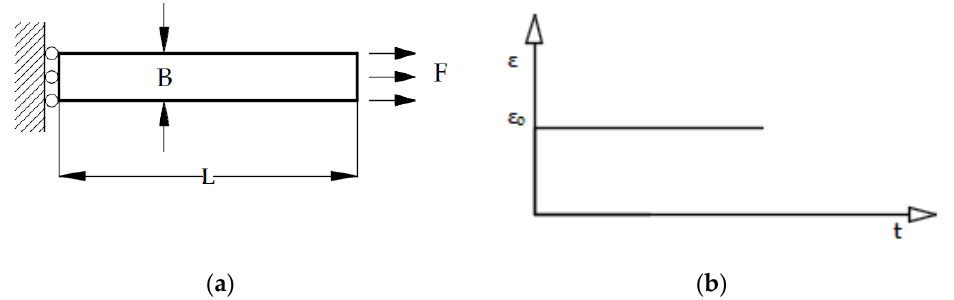
Figure 14. ( a ) Geometry and boundary conditions for the relaxation test (L = 80 mm, B = 10 mm); ( b ) constant loading for the relaxation test. ( b ) constant loading for the relaxation